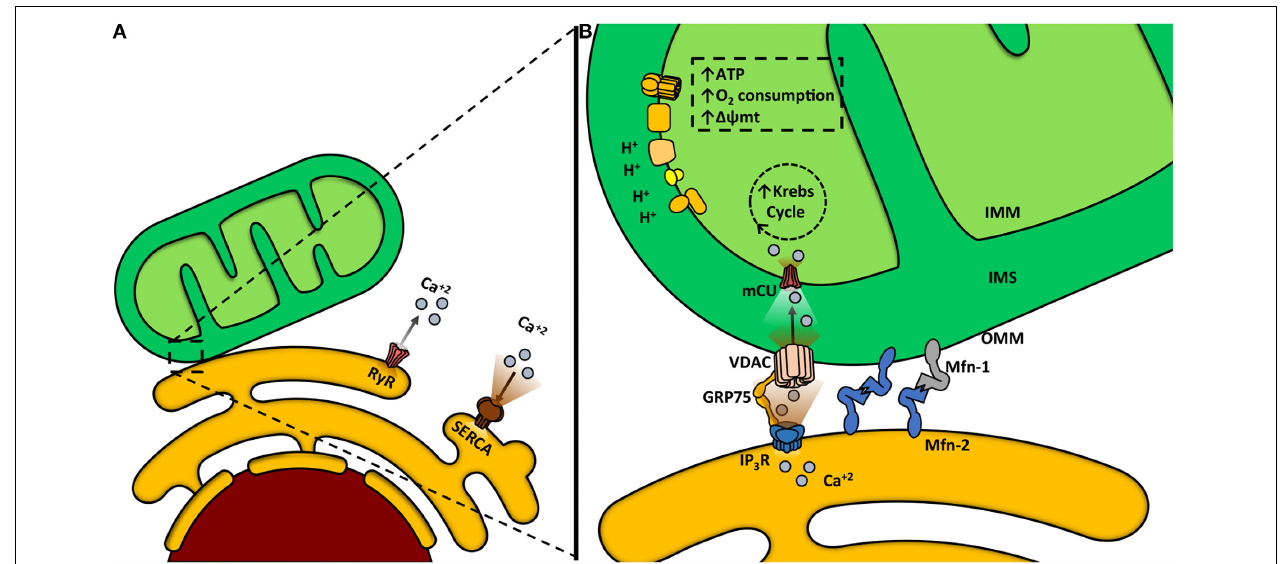
chaperone that mediates the molecular interaction between InsP3R with the voltage-dependent anion channel (VDAC). Ca 2 + import across the OMM occurs through VDAC. Ca 2 + crosses the IMM through the mitochondrial Ca 2 + uniporter channel (mCU) thanks to the considerable driving force represented by the negative transmembrane potential and the high Ca 2 + concentration within the intermembrane space. Increased mitochondrial Ca 2 + concentration activates mitochondrial dehydrogenases and enhances the oxidative phosphorylation, increasing oxygen consumption, (cid:2) ψ m and ATP